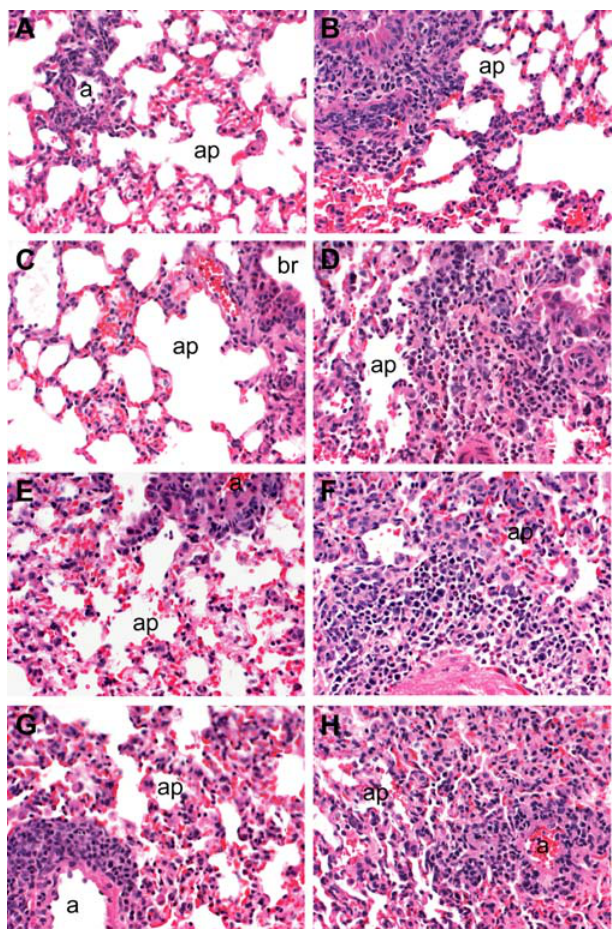
Figure 9. Kinetics of VRP-N–Associated Inflammation Light photomicrographs of lung sections taken from VRP-HA– and VRP- N–vaccinated mice harvested at days 2, 4, 7, and 14 post–icSARS-CoV challenge (Table 1, experiment 5). Representative lung sections (200 3 magnification) comparing pulmonary inflammation between VRP-HA– vaccinated (A), (C), (E), and (G) and VRP-N–vaccinated (B), (D), (F), and (H) mice. Enhanced inflammation was evident by day 2 (A) and (B) in some VRP-N–vaccinated animals relative to lung sections of VRP-HA–inocu- lated mice. By day 4 post-infection (C) and (D), increased inflammation in VRP-N–vaccinated animals was widely apparent and was maintained through days 7 (E) and (F) and 14 (G) and